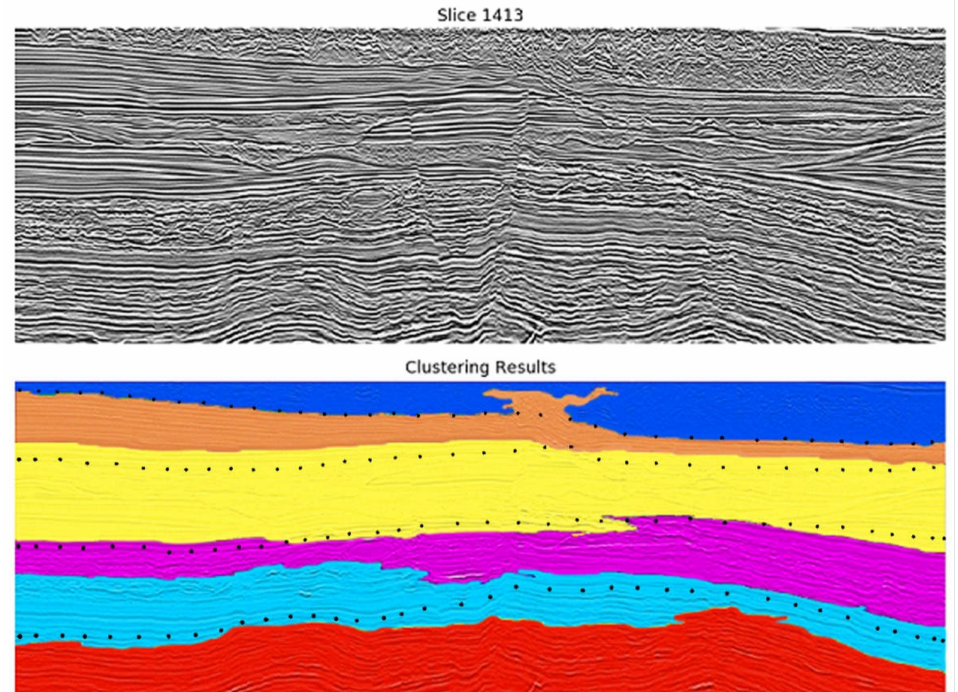
Figure 17. Results from the clustering of Watershed segments using k-Means (6 groups) with the best subset of features. The top image shows the original vertical seismic slice; the bottom one shows the Watershed results. Comparing this result with Figures 13–15, it can be concluded that the accuracy of the model was